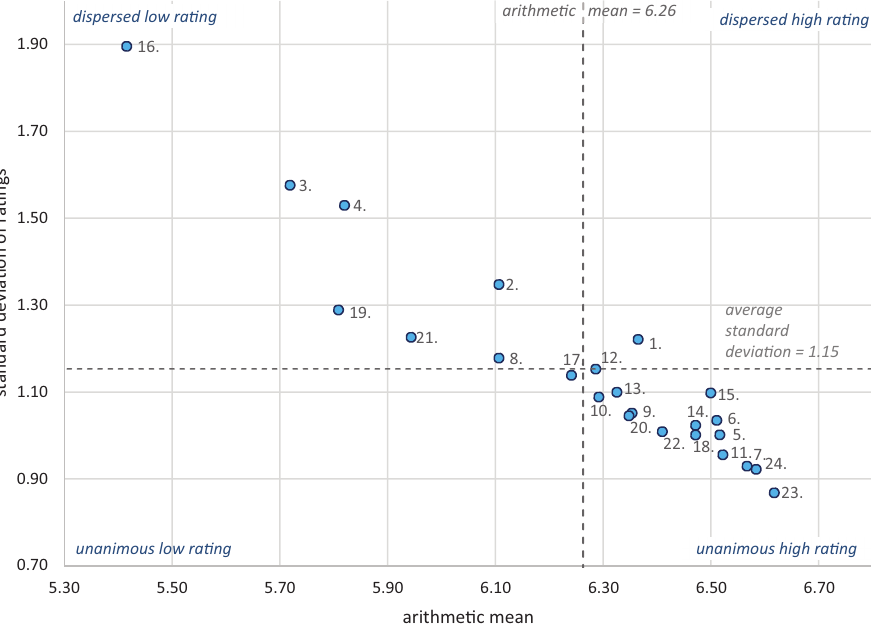
Figure 6. Distribution of 24 statements related to the ideal vocational guidance course